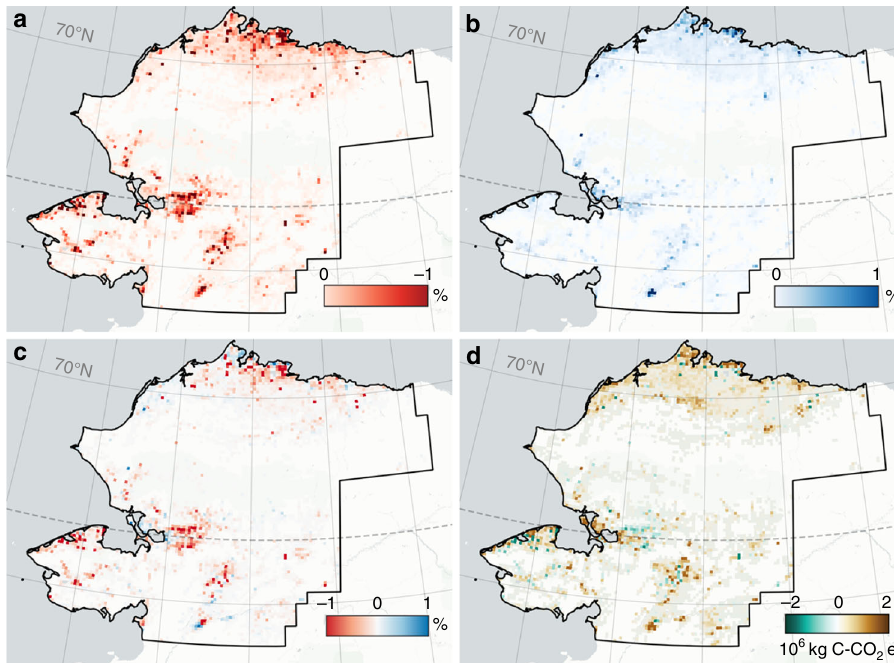
Fig. 3 Lake area change and carbon fl ux implications in the permafrost region of northwestern Alaska for 1999 – 2014 determined with Landsat satellite trend analysis. Gross lake area loss ( a ), gross lake area gain ( b ), net lake area change ( c ), and net change in carbon fl ux associated with expansion and drainage ( d ) have been aggregated in 7.5 km × 7.5 km grid cells (5625 ha per cell). Background map: CartoDB Positron layer accessed with QuickMapServices QGIS Plugin. Panels a – c show the absolute percent water fraction change per grid cell. In d , net change in carbon fl ux over the 15-year observation period. Despite a net lake area loss for the region, large permafrost-soil derived carbon emissions associated with gross lake area gain overwhelm smaller fl ux changes associated with gross lake area loss, leading to a net increase in regional carbon emissions (Supplementary Table